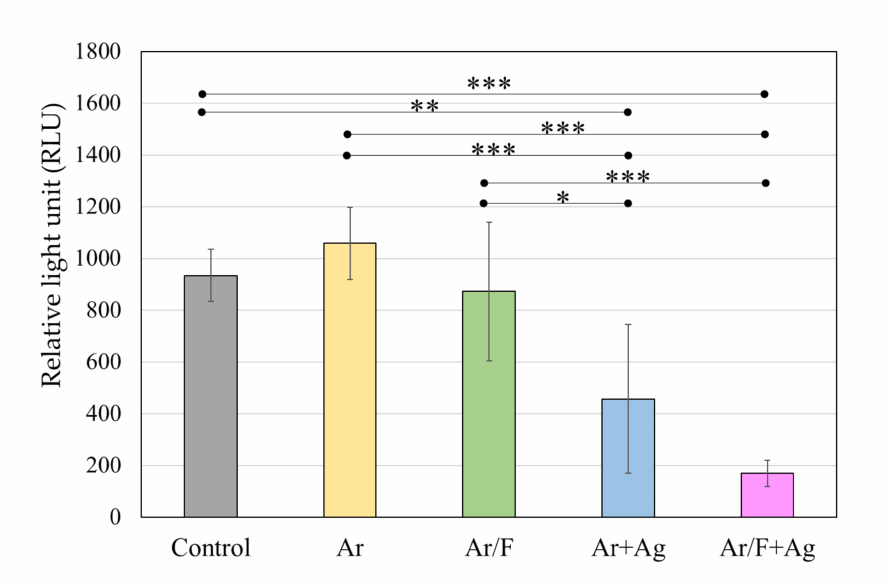
Figure 6. The luminescence intensity of the S. mutans suspension that was in contact with each specimen for four hours. * p < 0.05, ** p < 0.01, p < 0.001 (ANOVA / Tukey, α = 0.05).